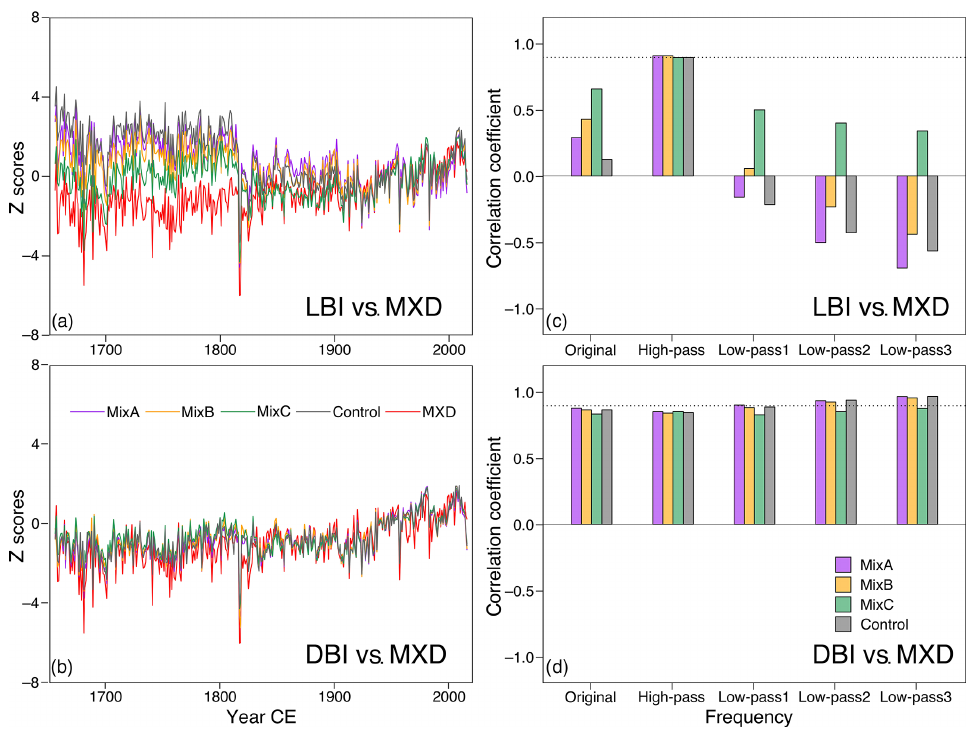
Figure 4. Comparisons of LBI (a, c) and DBI chronologies (b, d) for the MixA, MixB, MixC, and Control treatments against the reference MXD chronology. In (a) and (b) , chronologies are transformed to z scores relative to the 1901–2015 time interval. Panels (c) and (d) show correlations of LBI and DBI chronologies against MXD chronology at different timescales. Original: the original RCS standardized chronologies; high-pass: 10-year high-pass filtered series; low-pass 1, 2 and 3: 10-year, 50-year, and 100-year low-pass series filtered using the Butterworth filter. Dotted horizontal lines in the right panel show the correlation ( r = 0 . 89) between the high-pass-filtered LBI and MXD chronology.